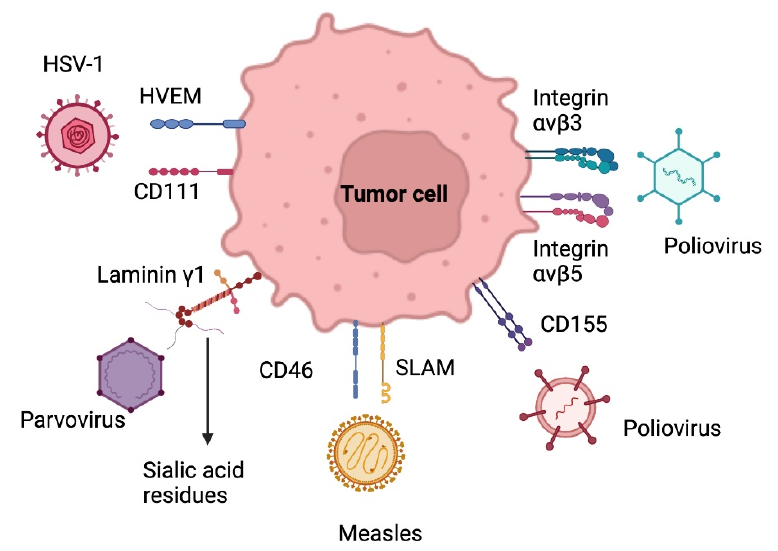
Figure 3. Target receptors of oncolytic virus therapy. HSV-1: Herpes simplex virus 1; HVEM: herpes virus entry mediator SLAM: signaling lymphocyte activation molecule. Created with BioRen- der.com.